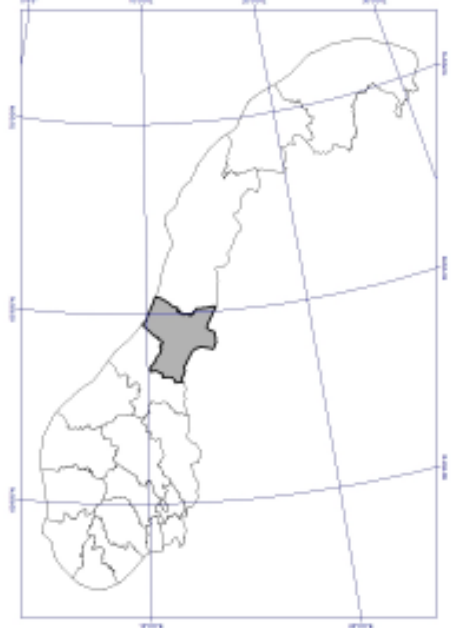
Figure 1. The location of the Nord-Trøndelag County (grey) in Norway